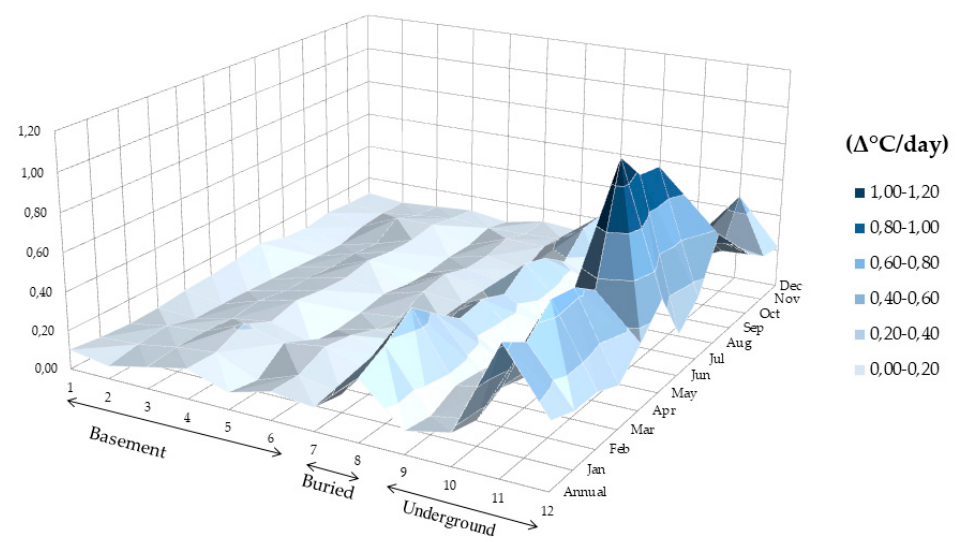
∆ ◦ C/day) inside the buildings